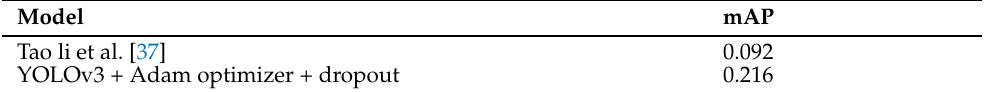
Table 17. Comparison between the YOLOv3 model and the state of-art models on the DDR dataset. Model